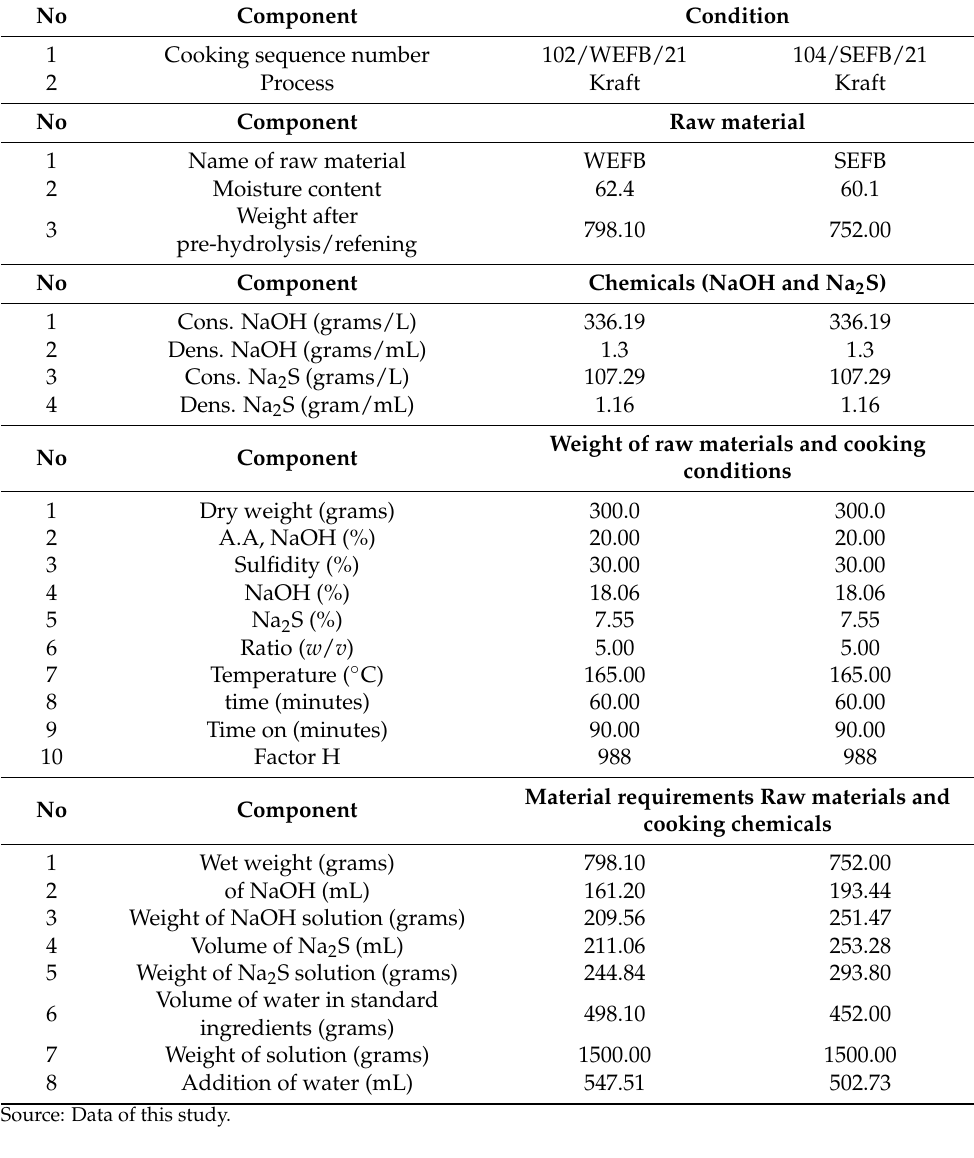
Table 2. Raw materials and ripening conditions for pulp of whole-empty fruit bunches (WEFB) and stalk-empty fruit bunches (SEFB).